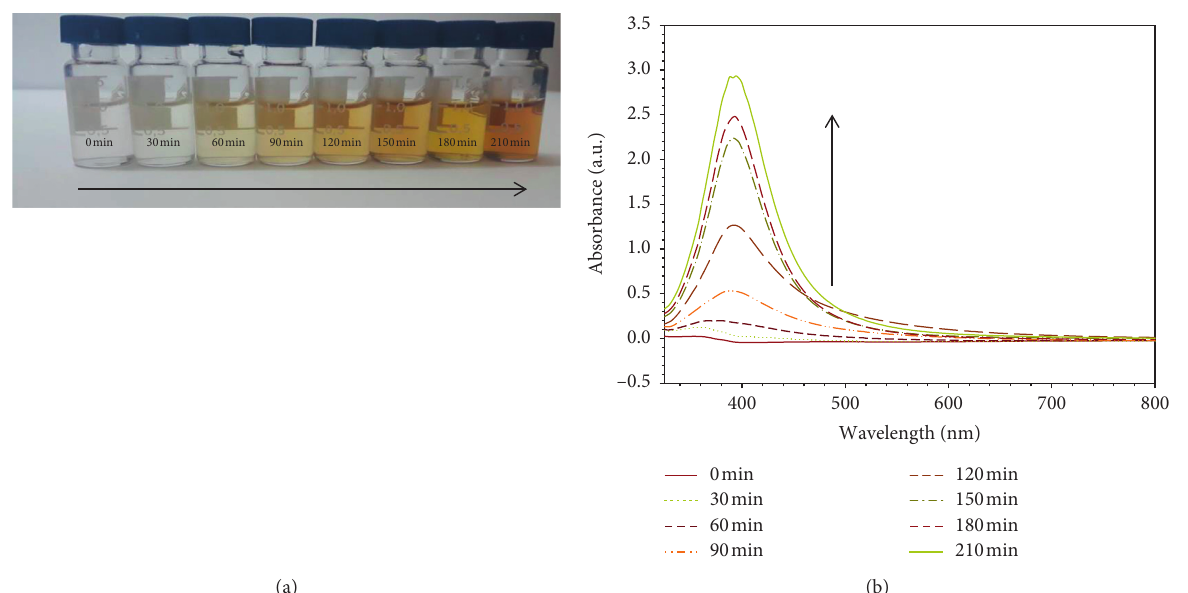
Figure 1: The appearances of silver nitrate solution and AgNPs colloids synthesized (a), and the UV-vis spectra of the formed AgNPs at various times of 0, 30, 60, 90, 120, 150, 180 and 210min